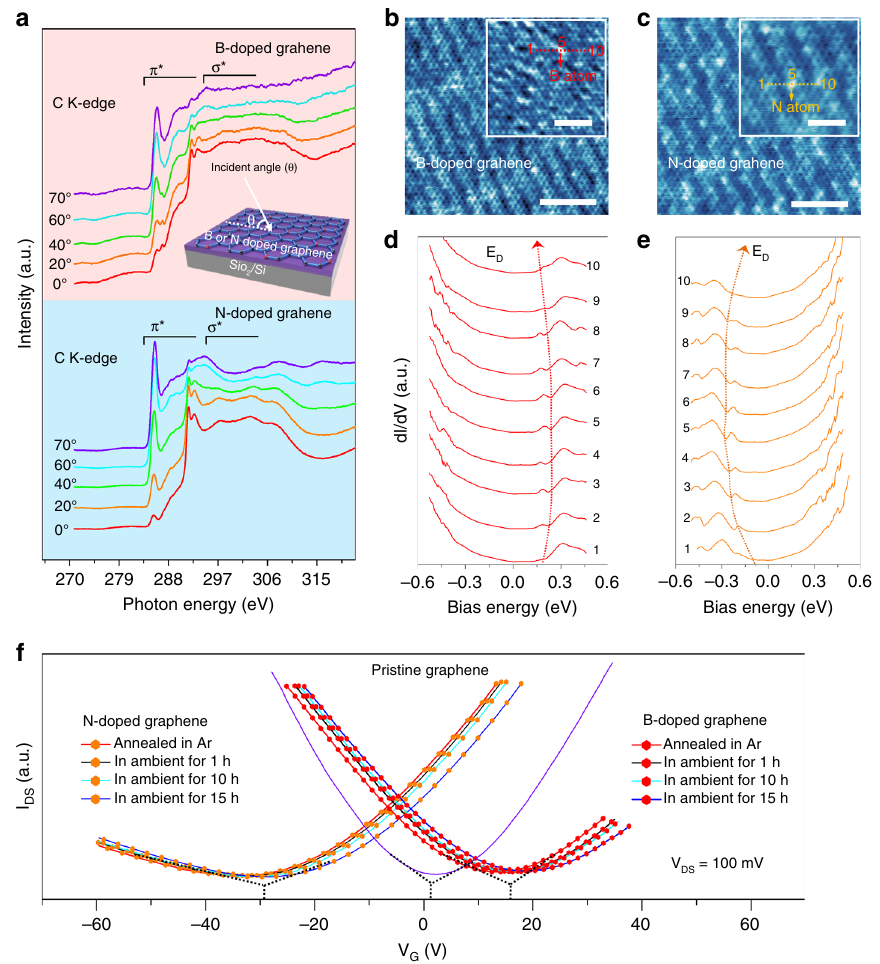
Fig. 3 Structural, bandgap, and stability studies of doped graphene. a TEY mode C K-edge NEXAFS spectra of B-doped and N-doped graphene transferred onto the SiO 2 /Si substrate acquired at different incident angles ( θ ). The inset shows the schematic of the test setup in the angle-dependent NEXAFS experiments. STM topographical images of b , B-doped on a Cu-Ni alloy substrate ( V bias = − 300 mV, I set = 200 pA) [scale bar = 5 nm] and c , N-doped graphene on a Cu-Ni alloy substrate ( V bias = 300 mV, I set = 200 pA) [scale bar = 5 nm]. The inset in each fi gure displays the selected region at a higher magni fi cation [scale bar = 1 nm]. d , e Representative STS spectra along the dashed arrows in the inset ( b , c ), showing the characteristic density of states in B-doped ( V bias = − 300 mV, I set = 300 pA) and N-doped graphene ( V bias = 300 mV, I set = 300 pA). The shift in the Dirac point is tracked by the red (orange) dotted line to show charge doping on the B (N) atoms. f Doping stability assessment of the B-doped and N-doped GFETs under ambient conditions for various time durations. N-doped and B-doped graphene synthesized by B and N ion implantation with the fl uence of 4 × 10 16 atoms/cm